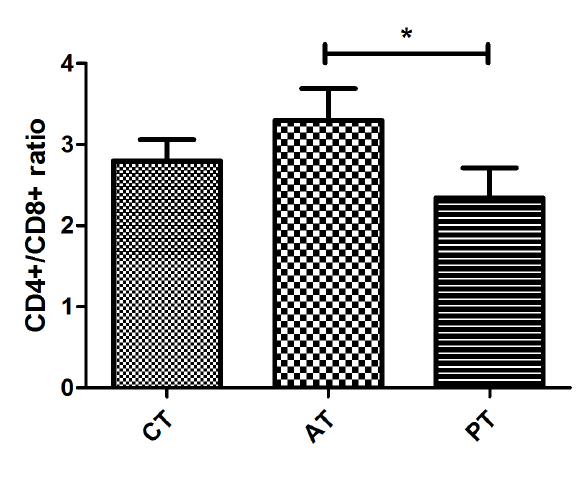
Table 2. Proportion of T cells (CD3 + ), T helper cells (CD4 + ), cytotoxic T cells (CD8 + ), natural killer cells (CD16 + ) and regulatory T cells (CD25 + ) in controls (CT), patients with active lesion (AT) and patients after chemotherapy (PT) CT AT PT CD3 64.12 ±5.41 61.38 ±3.91 63.13 ±5.7 CD4 38.17 ±4.78 39.75 ±1.8 42.09 ±5.9 CD8 14.70 ±4.33 13.35 ±4.27 19.58 ±5.36# Figure 2. CD4 + /CD8 + ratio in the peripheral blood of controls (CT), patients with active lesion (AT), CD16 11.92 ±6.11 12.02 ±3.72 10.89 ±6.21 and patients after chemotherapy (PT). Differences CD25 3.22 ±1.6 6.42 ±2.63# 12.91 ±2.82# between groups were considered significant when p < 0.05 and are indicated by asterisks (*).